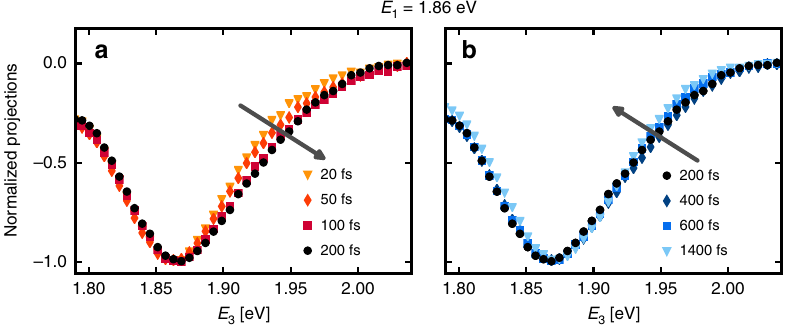
Fig. 4 Pseudo-TA spectra can be extracted from the 2D dataset. a The early-time projections show the rise of a tail to the blue as t 2 increases, inconsistent with previously reported cooling signatures. b The tail is observed to slightly decrease at later population times, indicative of the onset of